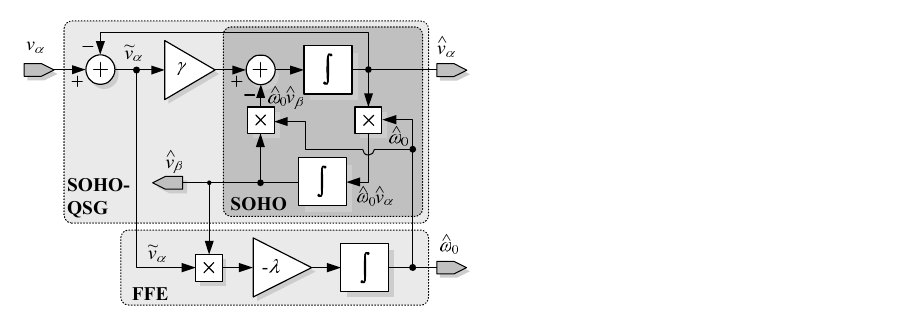
Figure 1. Block diagram of the proposed single-phase second-order harmonic oscillator (SOHO)- based frequency-locked-loop (FLL)